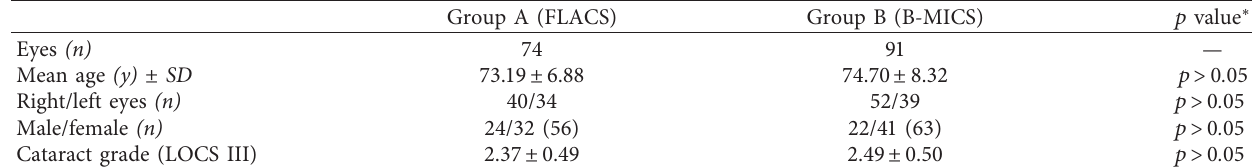
Table 1: Comparison of demographic data at baseline for both